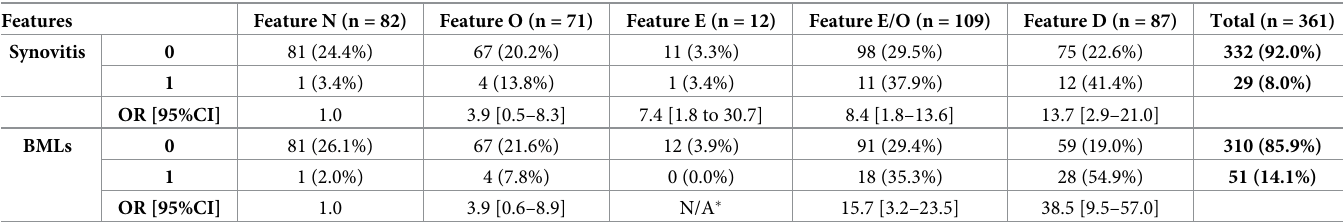
Binary logistic regression analyses were performed to describe and study the association. Joints without osteoarthritis (feature N) served as the reference. NA, not applicable—BMLs, bone marrow lesions—OR, odds ratio; 95%CI, confidence interval [–]. � any patient has Erosive Feature and